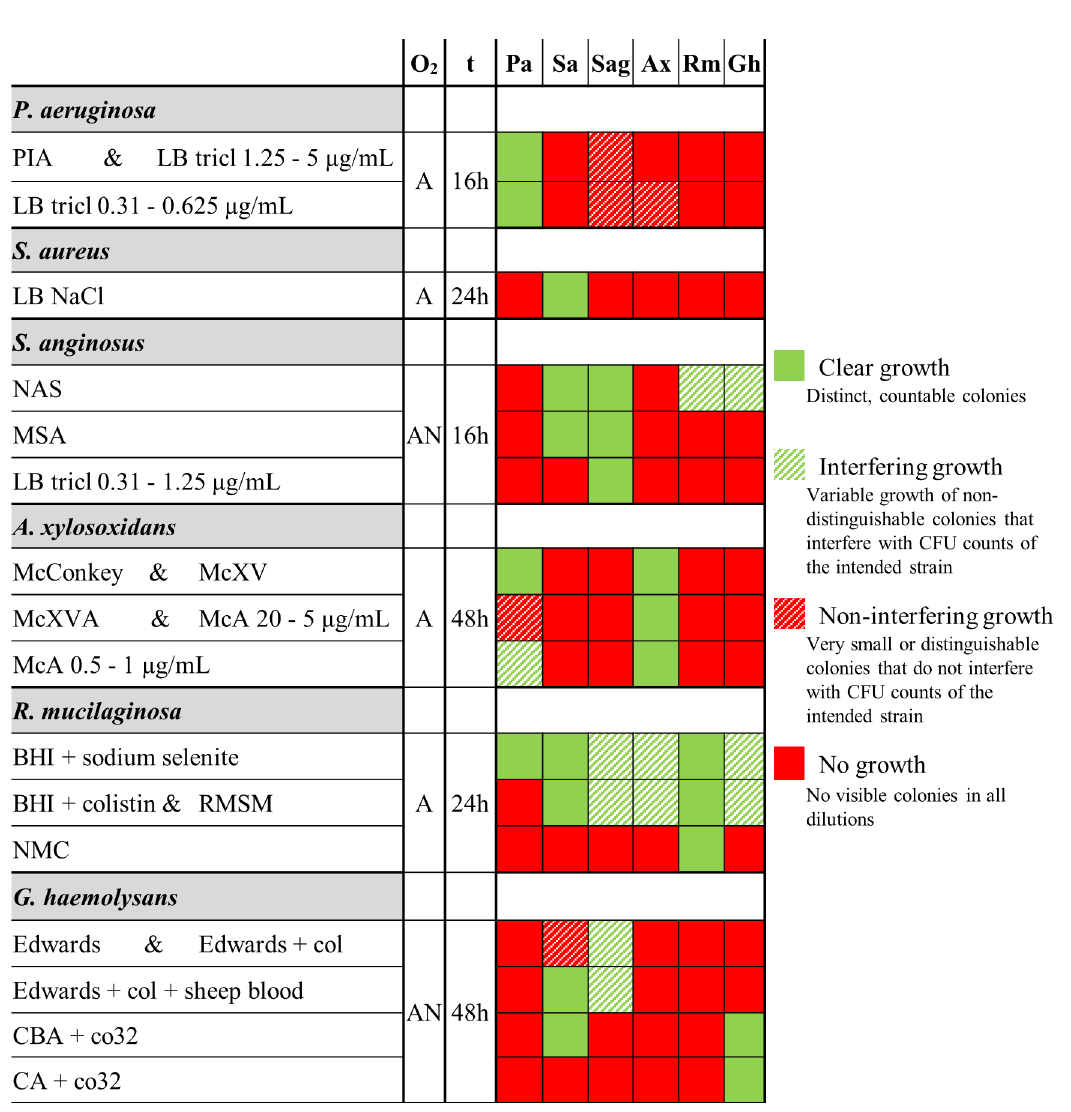
Fig 1. Overviewof selectivity experiments. The first column shows the intendedspecies and an abbreviated name of the medium, the second column (O 2 ) shows aerobic (A) or anaerobic(AN) incubation,and the third column (t) shows incubation times. Strains belongingto the same species showedthe same results. Pa : P . aeruginosa AA2, PAO1, and AA44; Sa : S . aureus SP123 and Mu50; Sag : S . anginosus LMG 14696 and LMG 14502; Ax : A . xylosoxidans LMG 26680 and LMG 14980; Rm : R . mucilaginosa DSM 20746 and ATCC 49042; Gh : G . haemolysans LMG 18984 and LMG 1068. Results are shownfor all tested media: Pseudomonas IsolationAgar ( PIA ), LB + triclosan ( LB tricl ), LB + 7.5% NaCl ( LB NaCl ), nalidixic acid sulphamethazine agar ( NAS ), Mitis-salivarius agar ( MSA ), McConkey + 5 mg/mL xylose + 20 μ g/mL vancomycin ( McXV ), McConkey + 5 mg/mL xylose + 20 μ g/mL vancomycin ( McXV ) + 20 μ g/mL aztreonam( McXVA ), McConkey+ aztreonam ( McA ), Rothia mucilaginosa selective medium (RMSM), nutrient agar + 5 μ g/mL mupirocin+ 10 μ g/ mL colistin sulphate ( NMC ), Edwardsmedium + 10 μ g/mL colistin sulphate ( Edwards + col ), Columbiablood agar +